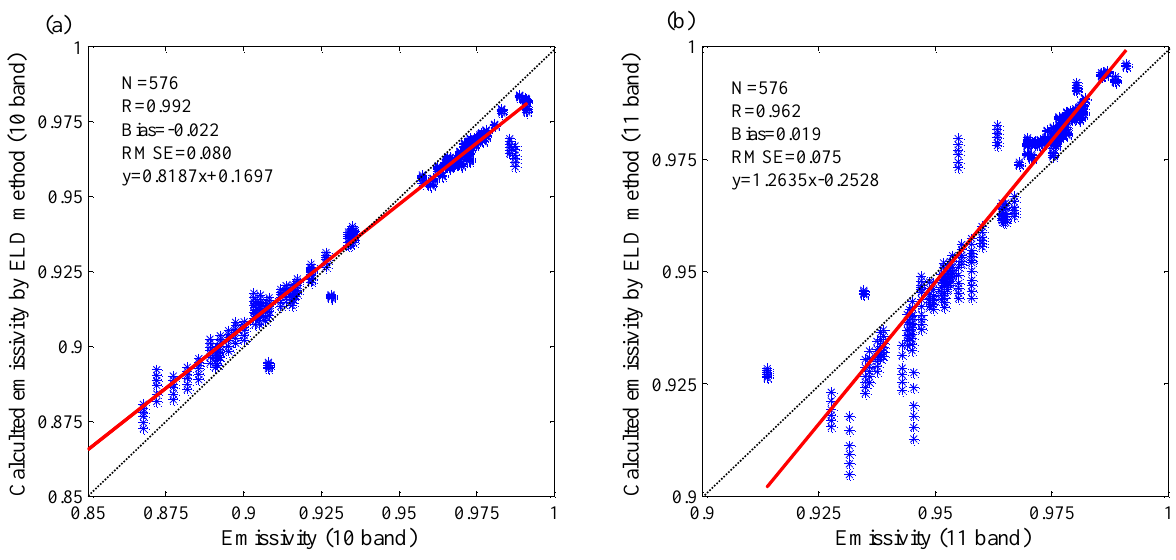
Figure 3. Accuracy evaluation of the ELD method based on the simulated dataset. The results are based on the simulation dataset by the MODTRAN model. ( a ) shows the comparison between the calculated and the reference emissivity of band 10, and ( b ) has a similar meaning. N is the number of simulation data, Bias is the average difference between the calculated and the reference emissivity, RMSE is the root mean square